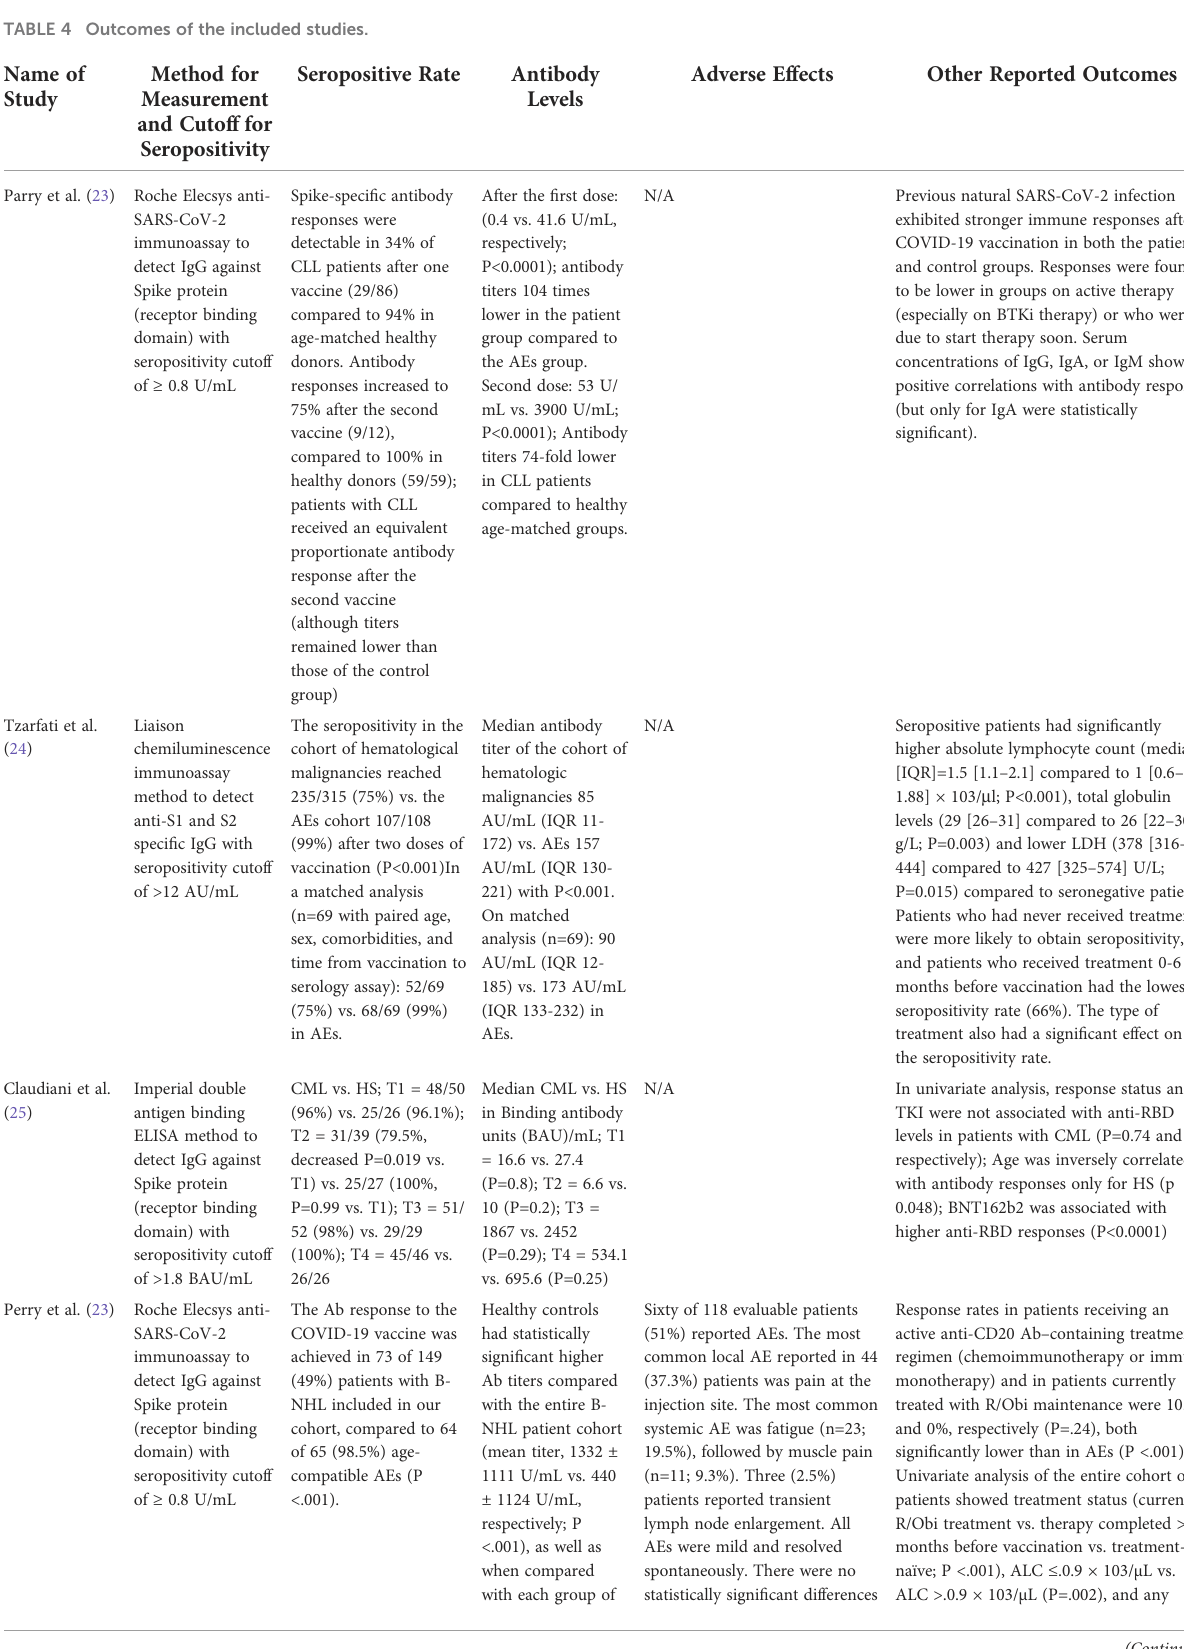
TABLE 4 Outcomes of the included